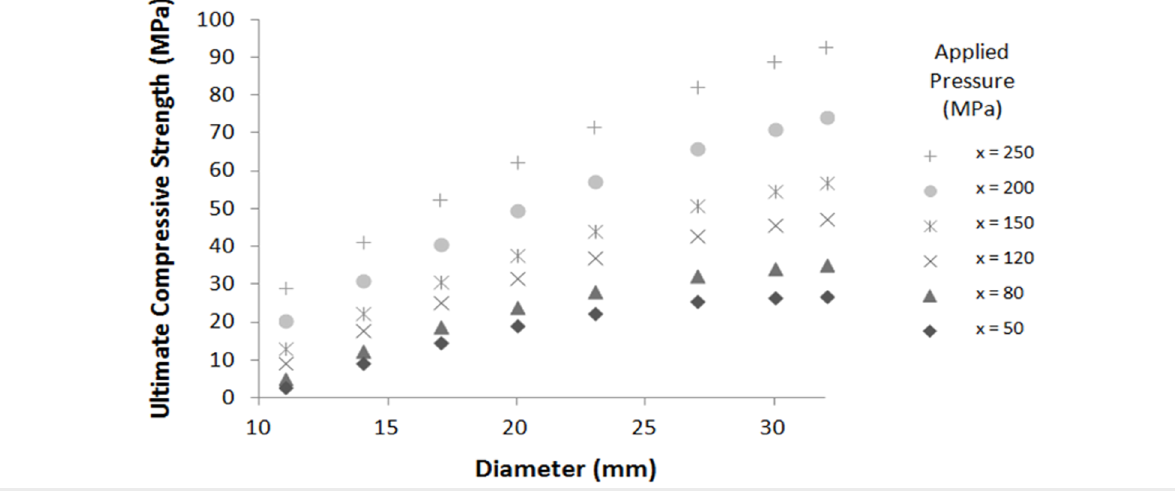
Figure 2: Ultimate compressive strength calculated by using Equation 1 for different pellet diameters and applied pressures (pellet height = 4.5 mm).